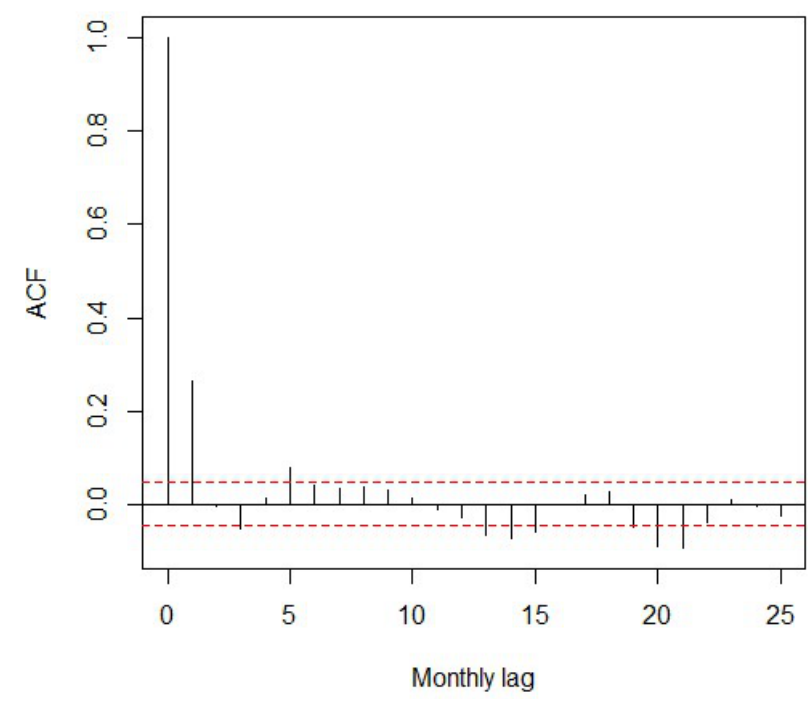
Figure 2. Monthly real rates of linear return. Autocorrelation function.